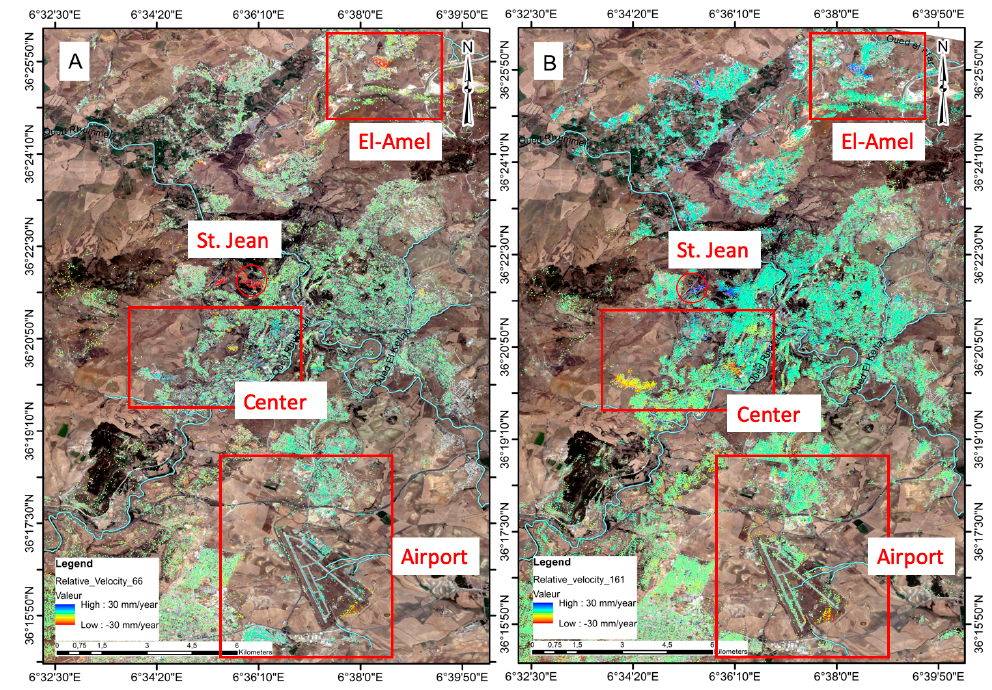
Figure 7. Line-of-sight (LOS) mean deformation velocity map of Constantine of tracks 66 in ( A ) and 161 in ( B ) respectively.